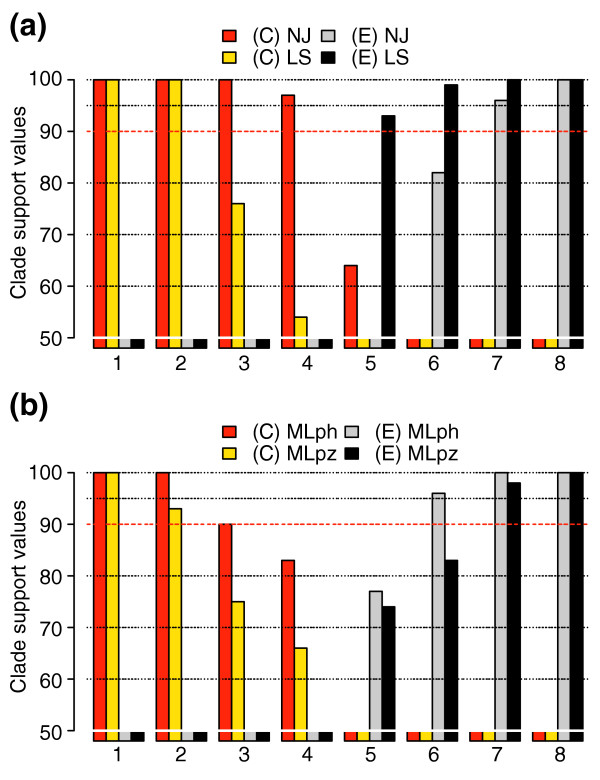
Bootstrap and reliability support for alternative topologies. Bootstrap and reliability support (50% majority consensus rule) for Coelomata (C) and Ecdysozoa (E) hypotheses derived from each one of the eight Mi matrices. (a) Distance methods. LS, least squares; NJ, neighbor joining. (b) Maximum likelihood, using PHYLIP (ph) and PUZZLE (pz). Highly supported trees were considered those with values above 90% (dotted red line).